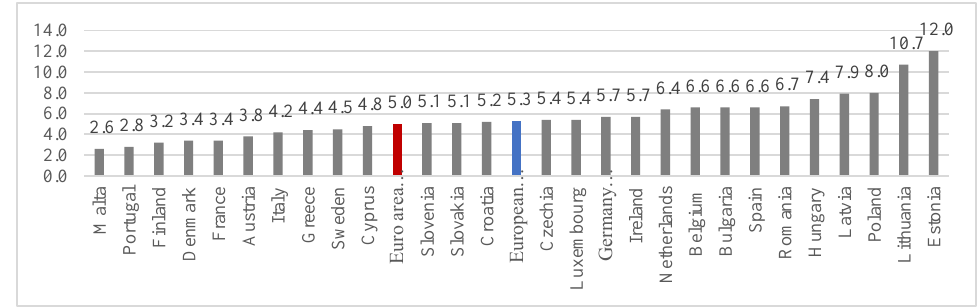
Figure 1. Annual Inflation Rates (in %) in December 2021. Supranational entities are in red and blue. Source dataset: Eurostat (1).